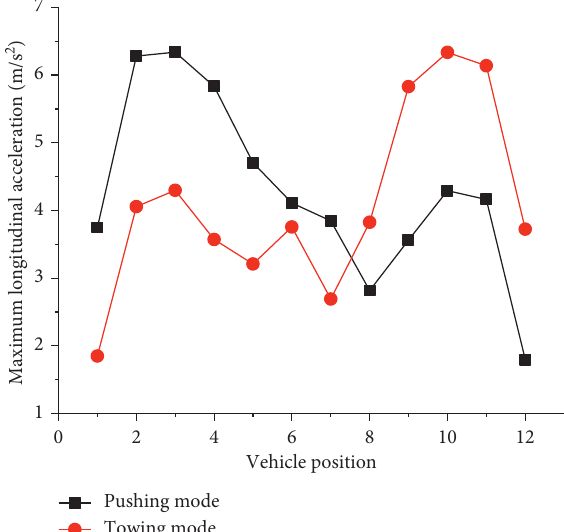
Figure 5: Maximum longitudinal acceleration when AW0 rescues AW0.